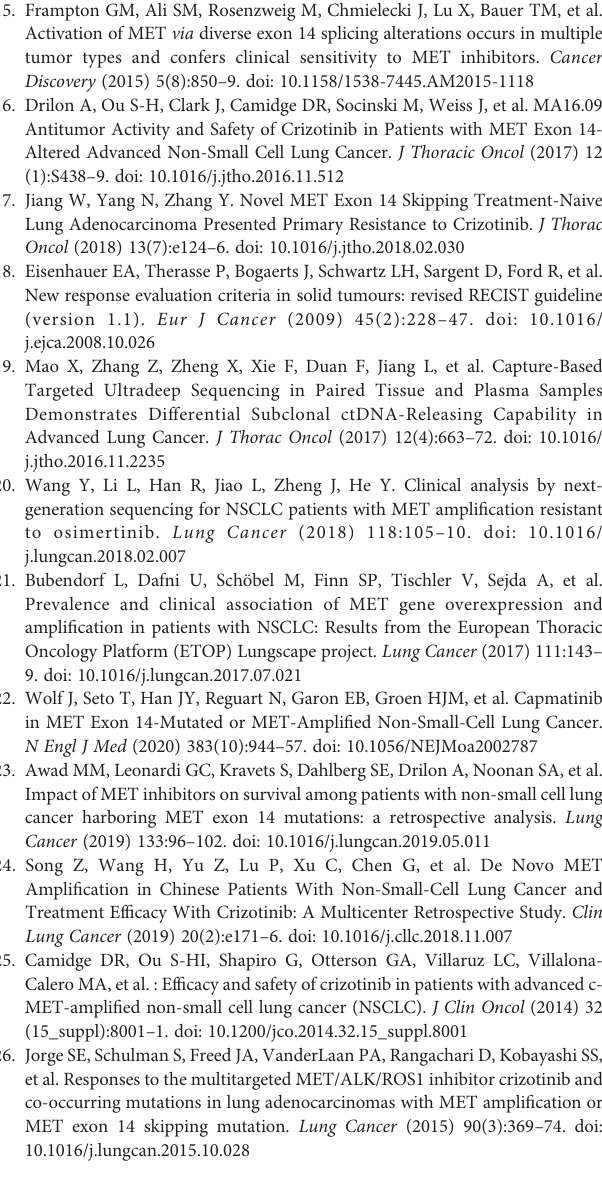
Supplementary Figure 1 | NSCLC patients with MET intermediate ampli fi cation showed shorter survival outcomes compared to high MET ampli fi cation with MET TKI therapy. Kaplan-Meier curves of PFS (A) and OS (B) of patients treated with MET TKIs in the intermediate and high MET ampli fi cation cohorts. Supplementary Figure 2 | NSCLC patients with MET ampli fi cation harboring PIK3CA mutations have shorter PFS with MET TKI therapy. Kaplan-Meier curves of PFS (A) and OS (B) of patients treated with MET TKIs based on presence or absence of concurrent PIK3CA mutation in the MET ampli fi cation